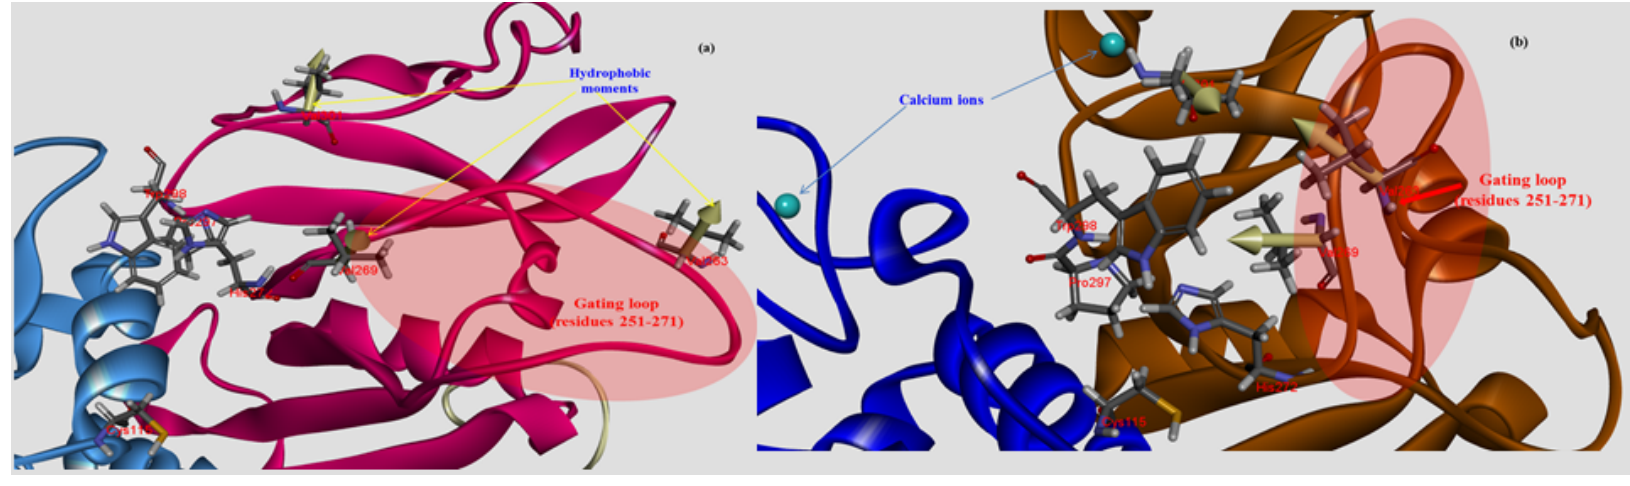
Figure 8. The key movements of Cys115 close to His272 for deprotonation of the former to occur involve a rotation of Trp298 in DII ( a ) Trp298 and Pro297 residues of the bovine CAPN1 in the inactive conformation blocking the active site and the adjacent equivalent region of Trp298 and Pro297 residues; ( b ) At the same time as undergoing major conformational changes upon activation, the Trp298 residue shifts to form an exposed position in the cleft to intrude into a hydrophobic patch formed by the rearrangement of the Ca 2+ -binding loops. Thus, the side chains of hydrophobic residues (Val269, Val301, and Val 263) reorient towards the interior Trp298 to give some indication of the preferred orientation of the hydrophobic moment vectors to facilitate stabilizing Trp298 in the bovine CAPN1 protease core due to cooperativity of these residues and open conformer of the flexible loop (residues 251–271) in DII from the protease core